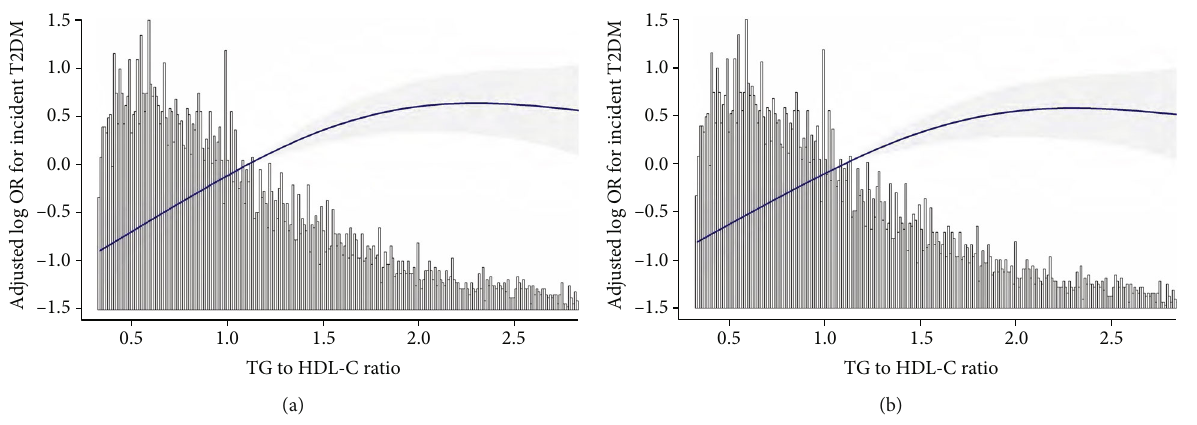
Figure 2: (a) Threshold e ff ect analysis of TG/HDL-C on the incidence of T2DM in the REACTION study. Notes: adjusted for age, sex, and body mass index. (b) Threshold e ff ect analysis of TG/HDL-C on the incidence of T2DM in the REACTION study. Notes: adjusted for age, sex, body mass index, histories of hypertension, tumor, stroke, and coronary heart disease, smoking status, alcohol intake, low-density lipoprotein cholesterol level, strenuous activity, education level, and family histories of T2DM and